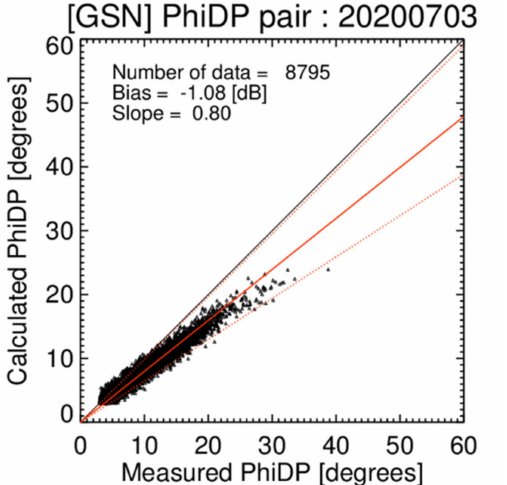
Figure 4. Scatter plot of the calculated and measured differential phase from GSN radar for the rainfall event on 3 July 2020. The red solid line represents the calibration bias ( ε SC ), while the red dashed lines represent the ε SC ± 1